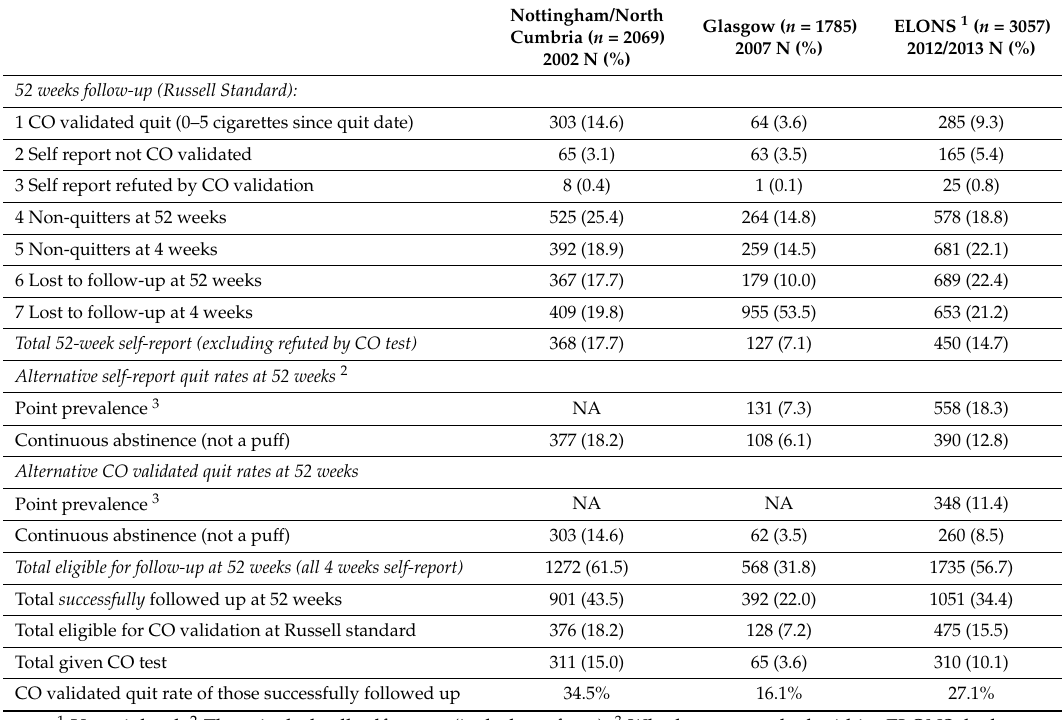
Table 1. Quit rates and follow-up